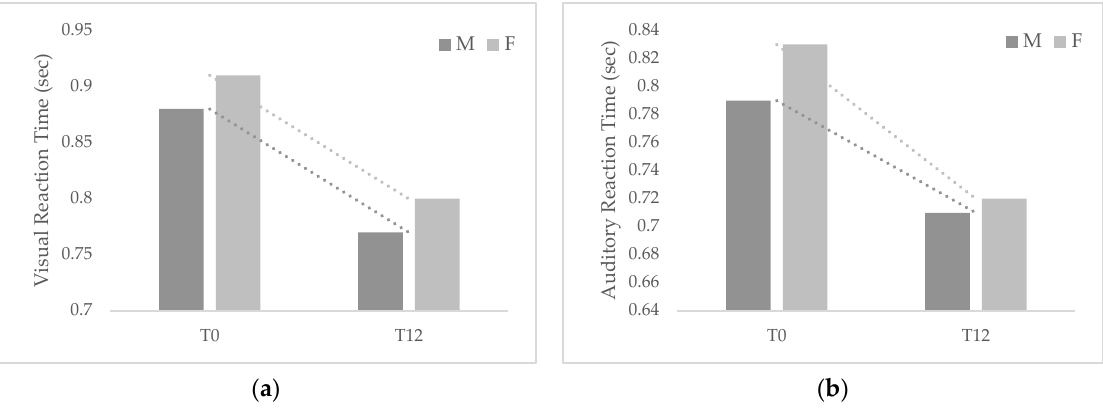
Figure 1. Changes occurred between baseline and 1-year follow-up in visual ( a ) and auditory ( b ) reaction times among male (M) and female (F) participants.